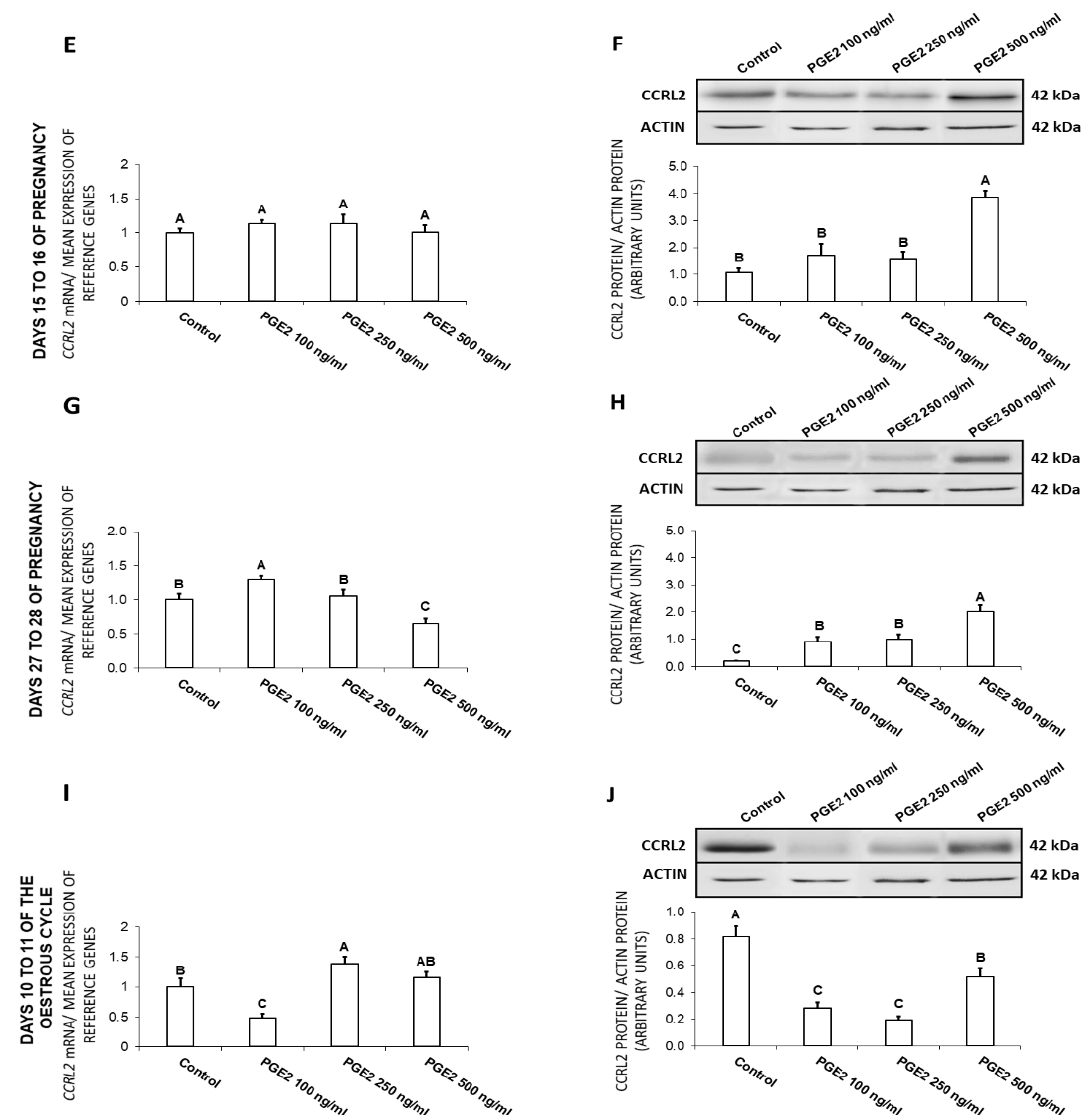
Figure4. TheinfluenceofprostaglandinE 2 (PGE 2 ; 100, 250, 500ng / mL)onC-Cmotifchemokinereceptor like 2 (CCRL2) mRNA ( A , C , E , G , I ) and protein ( B , D , F , H , J ) expression in the porcine endometrium on days 10 to 11, 12 to 13, 15 to 16, and 27 to 28 of the pregnancy, and on days 10 to 11 of the estrous cycle. The gene expression was determined by quantitative real-time PCR. The protein concentration was determined by the western blotting analysis; upper panels: Representative immunoblots; lower panels: Densitometric analysis of CCRL2 protein relative to actin protein. Results are reported as the means ± S.E.M. ( n = 5). Bars with di ff erent superscripts di ff er ( p <